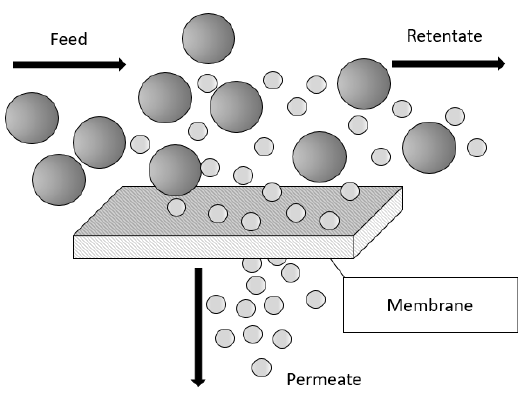
Figure 2. Schematic of membrane separation.